Question: Is the quantity shown trending increasing or decreasing?
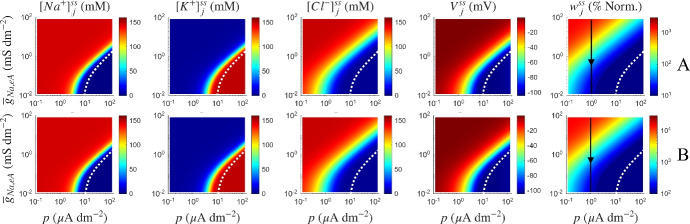
Answer: decreasing